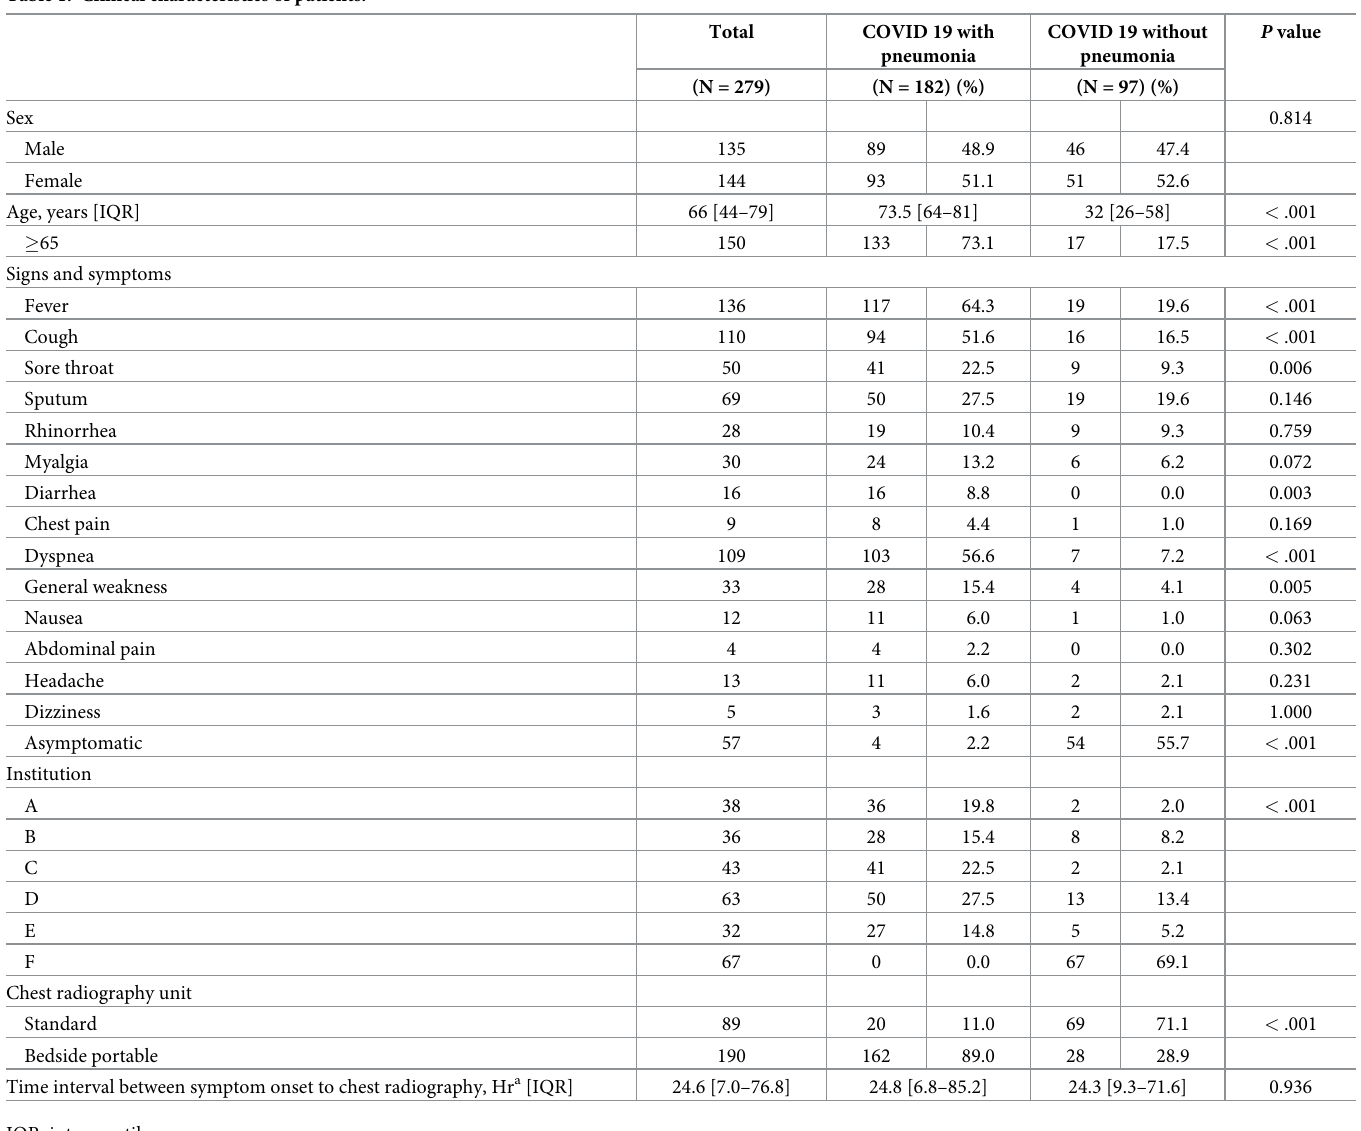
Table 1. Clinical characteristics of